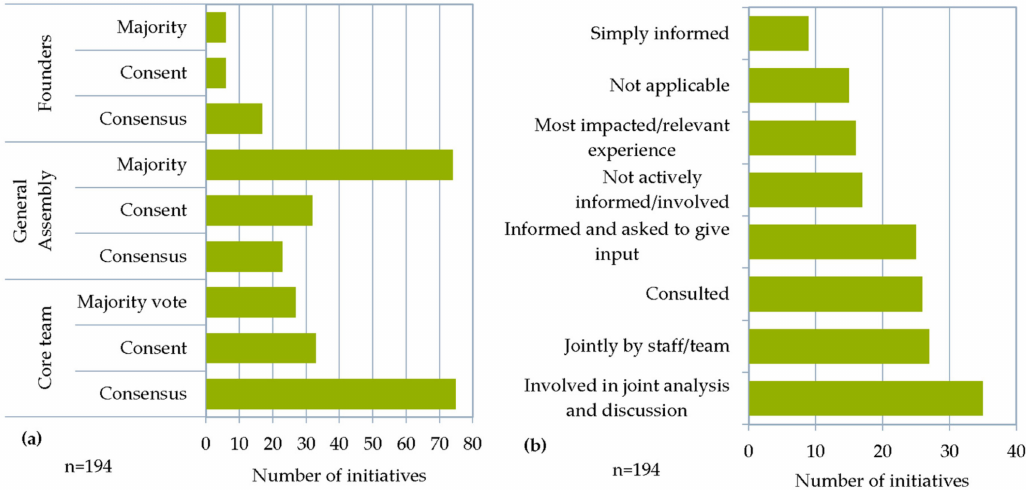
Figure 9. Strategic decision-making at the initiative: ( a ) at three levels of decision-making; ( b ) according to degree of involvement of sta ff